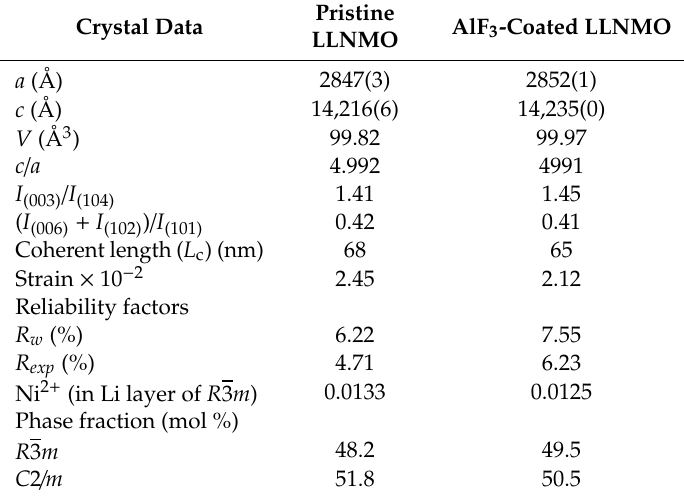
Table 2. The structural parameters obtained from Rietveld refinements for pristine and AlF 3